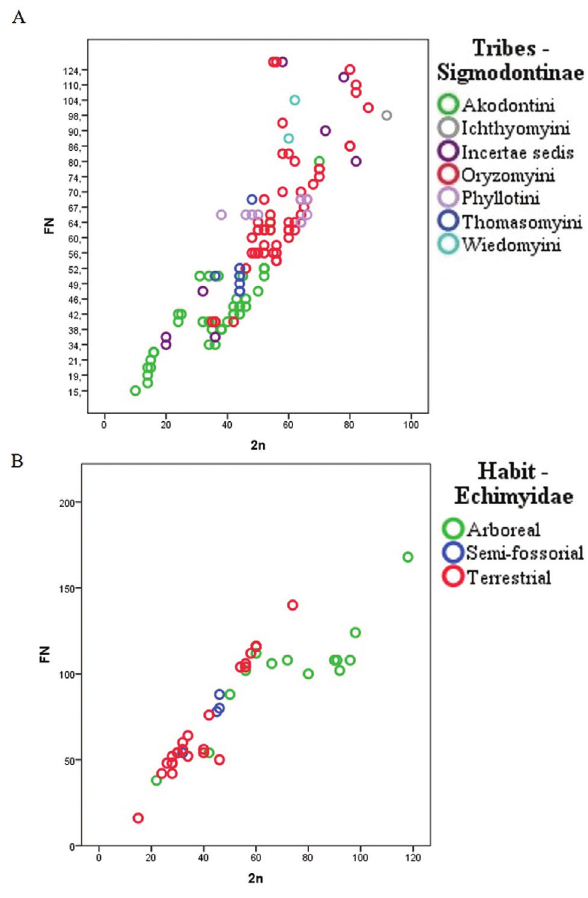
Figure 1 - Diploid (2n) and Fundamental numbers (FN) variation between (A) species belonging to the Subfamily Sigmodontinae Wagner, 1843 and (B) species of the family